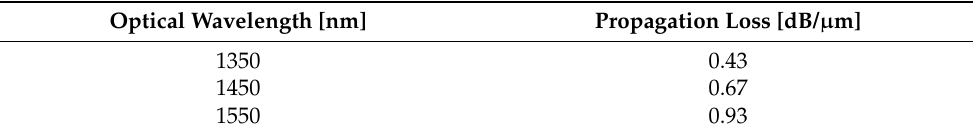
Table 3. Calculated propagation loss with different wavelengths of 1350, 1450, and 1550 nm, for fixed Si core layer thickness of 250 nm, SiO 2 buffer layer thickness of 100 nm, and Co layer thickness of 200